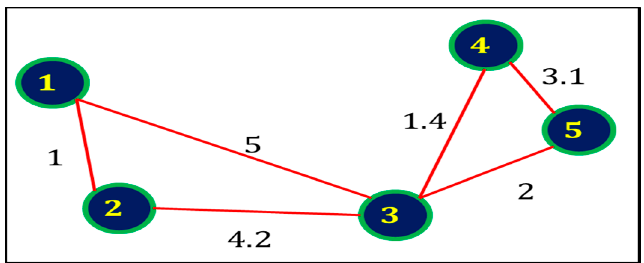
Figure 29. The dissimilarity graph among five SN users.